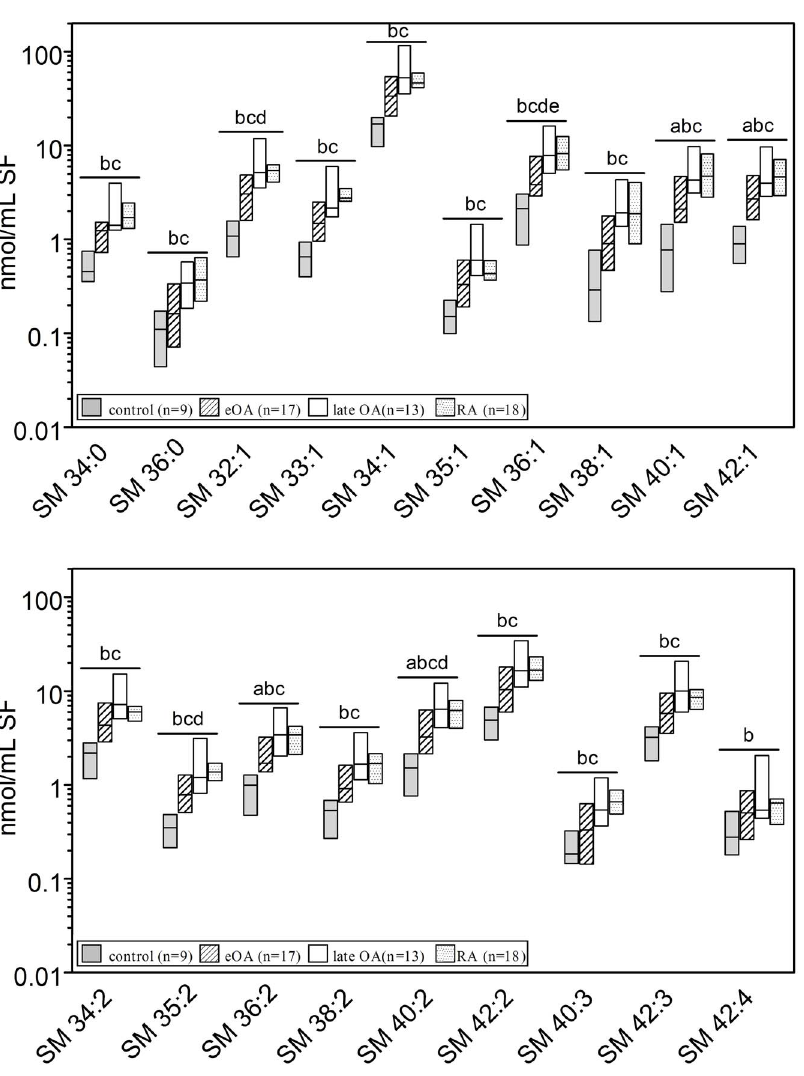
Figure 2. Concentrations of sphingomyelin species in human knee synovial fluid. Synovial fluid was obtained from donors serving as controls and from patients with early osteoarthritis (eOA), late OA (lOA), and rheumatoid arthritis (RA). SM species were determined by electrospray ionization tandem mass spectrometry as outlined in Material and Methods . Species annotation is based on the notion that 2 hydroxyl groups are linked to a sphingoid base. Values are presented as median and interquartile range. Significance was considered in the following way: a: p # 0.05: control vs eOA; b: p # 0.05: control vs lOA; c: p # 0.05: control vs RA; d: p # 0.05: eOA vs lOA; and e: p # 0.05: eOA vs RA. SM- sphingomyelin.